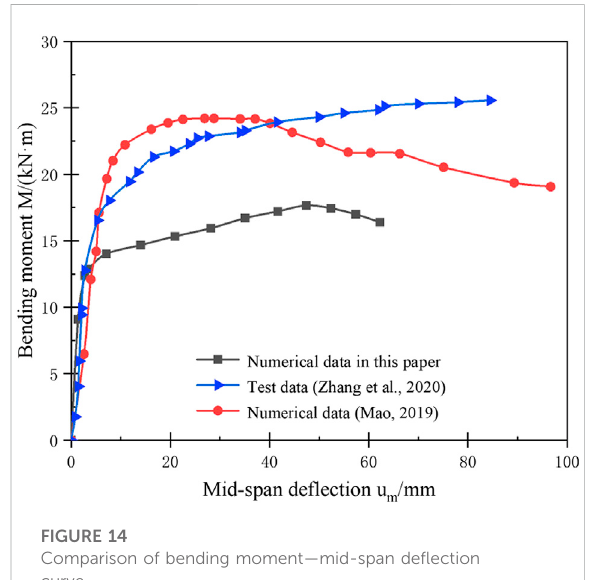
FIGURE 14 Comparison of bending moment — mid-span de fl ection curve.